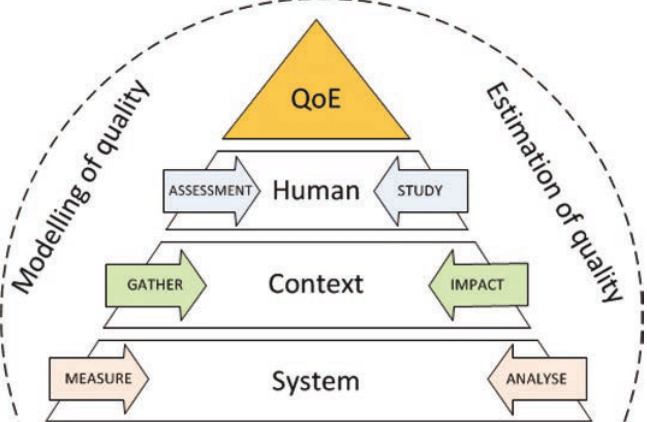
Figure 2. Multimedia quality evaluation methodology (source: